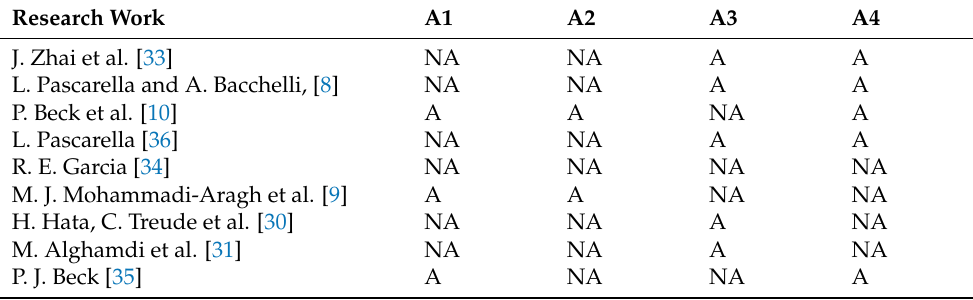
Table 2. Analysis of existing research (A = Addressed, NA = Not